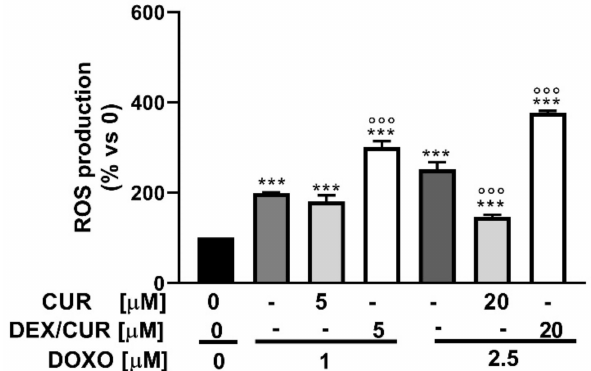
Figure 11. ROS levels (expressed as % of ROS production compared to the control) determined by FACS analysis using the CM-H2DCFDA probe in PC-3 cells after treatment with DOXO (1.0 and 2.5 µ M) in combination with CUR and DEX/CUR (5 and 20 µ M CUR equivalent concentration). Data were reported as mean values ± SD of three independent experiments. Two-way ANOVA followed by Dunnett’s method: *** p < 0.0001, compared to DOXO single treatments. ◦◦◦ p < 0.0001 vs. CUR or DEX/CUR single